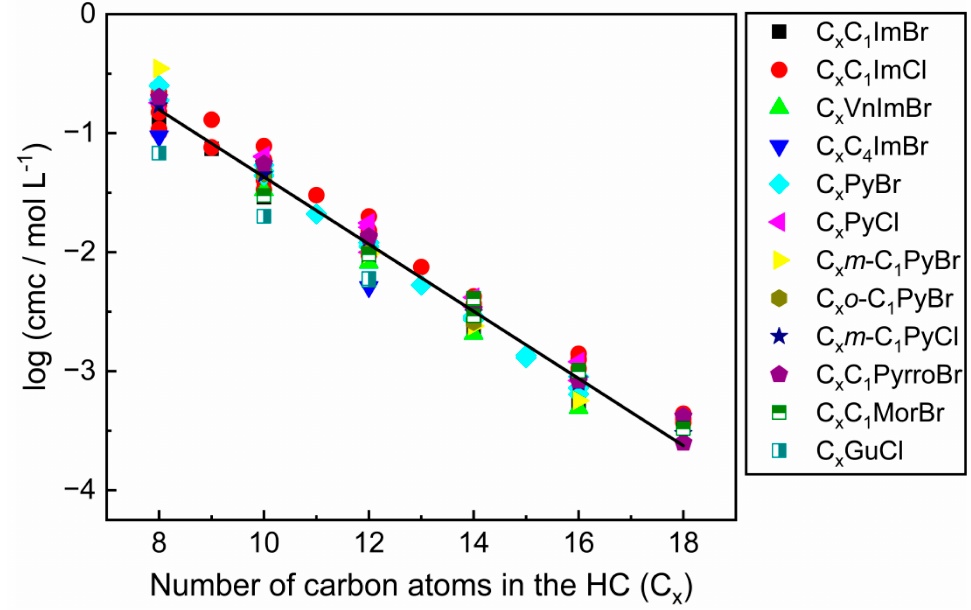
Figure 3. Dependence of log cmc on the number of carbons in the hydrophobic chain (C x ) for cationic ionic liquid-based surfactants. Data taken from conductivity measurements. The abbreviations of the surfactant head-ions are those listed in the footnotes of Table 1.